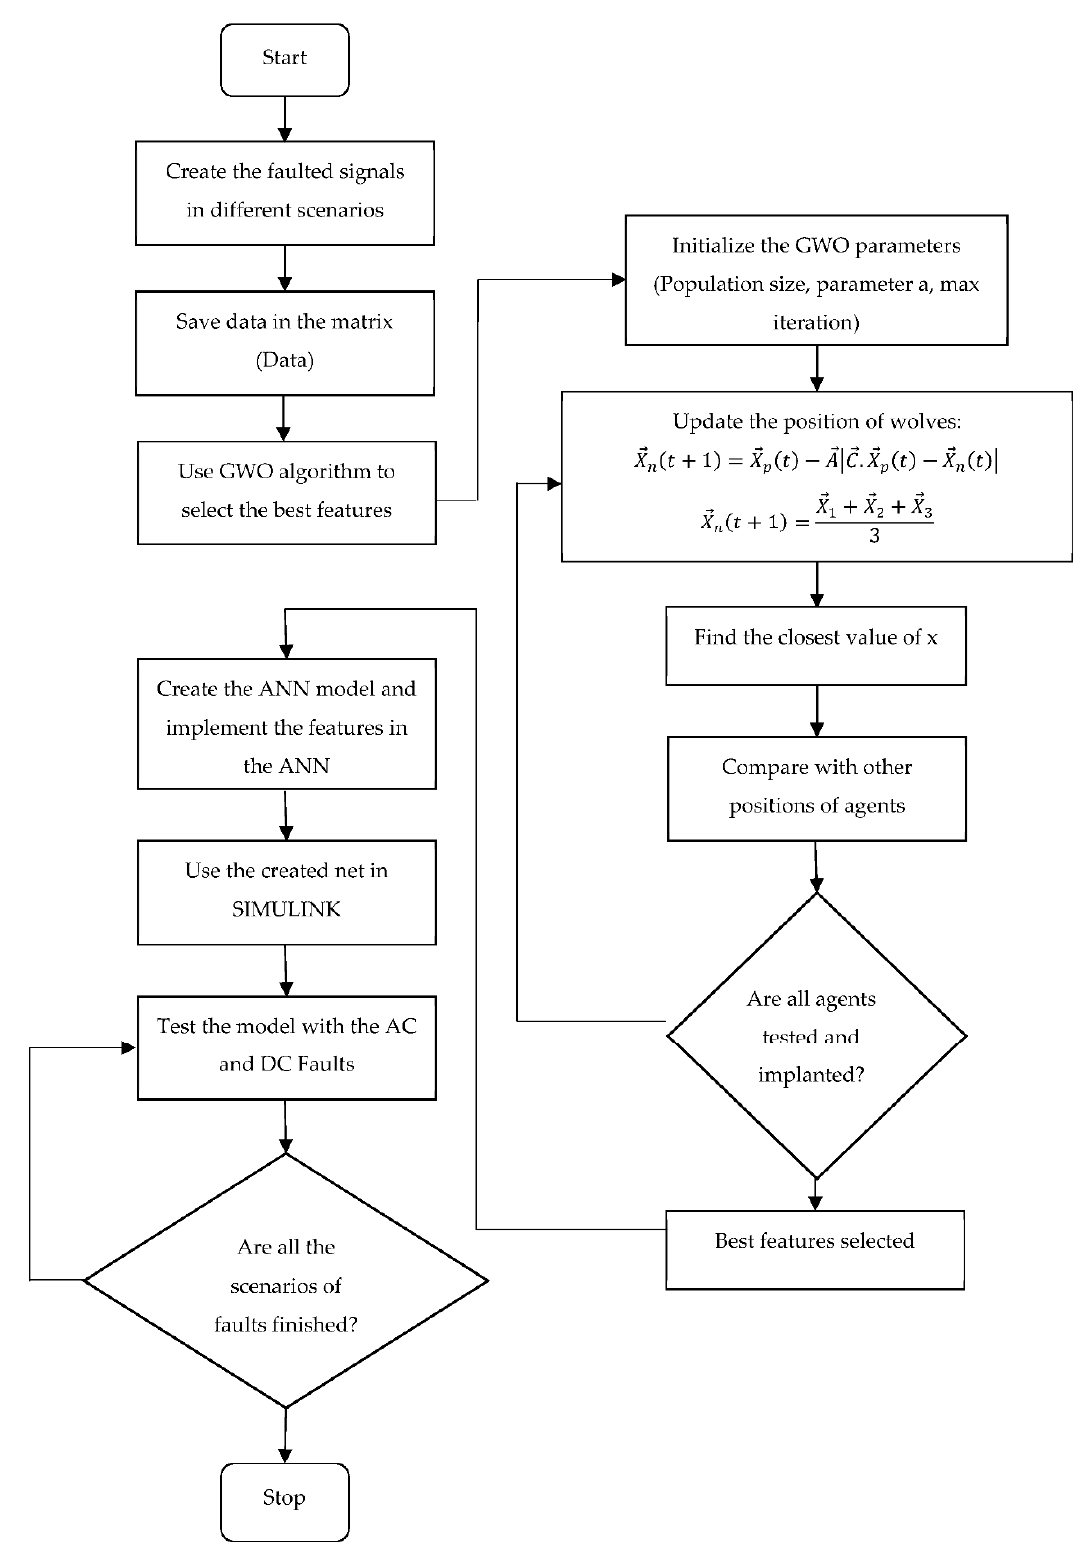
Figure 1. Summary of the proposed method for HVDC fault detection.